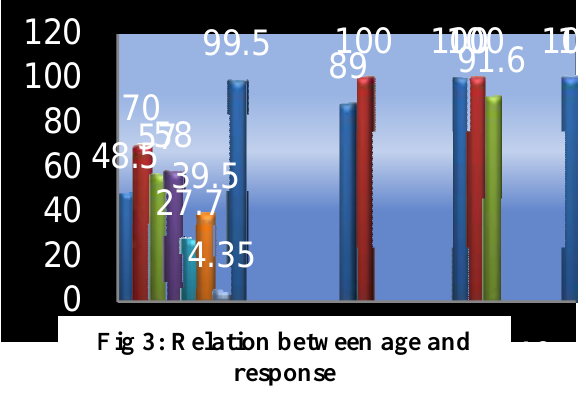
Fig 3: Relation between age and